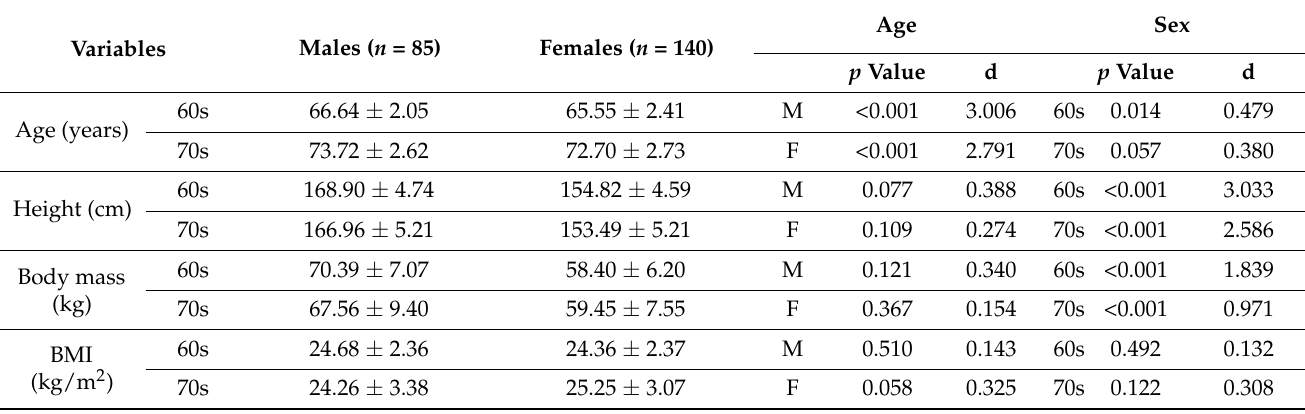
Table 1. Demographic and physical characteristics of the